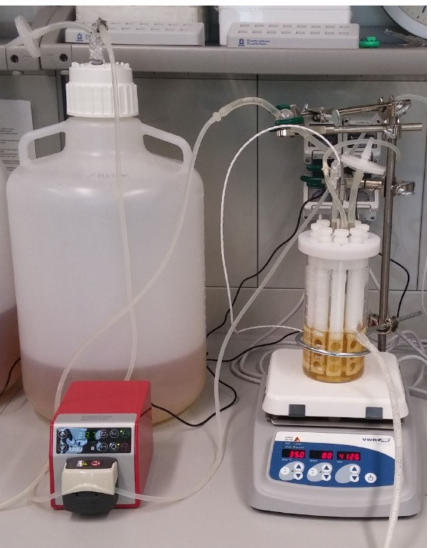
Figure 8. CDC biofilm reactor (BioSurface Technologies, Bozeman, MT,